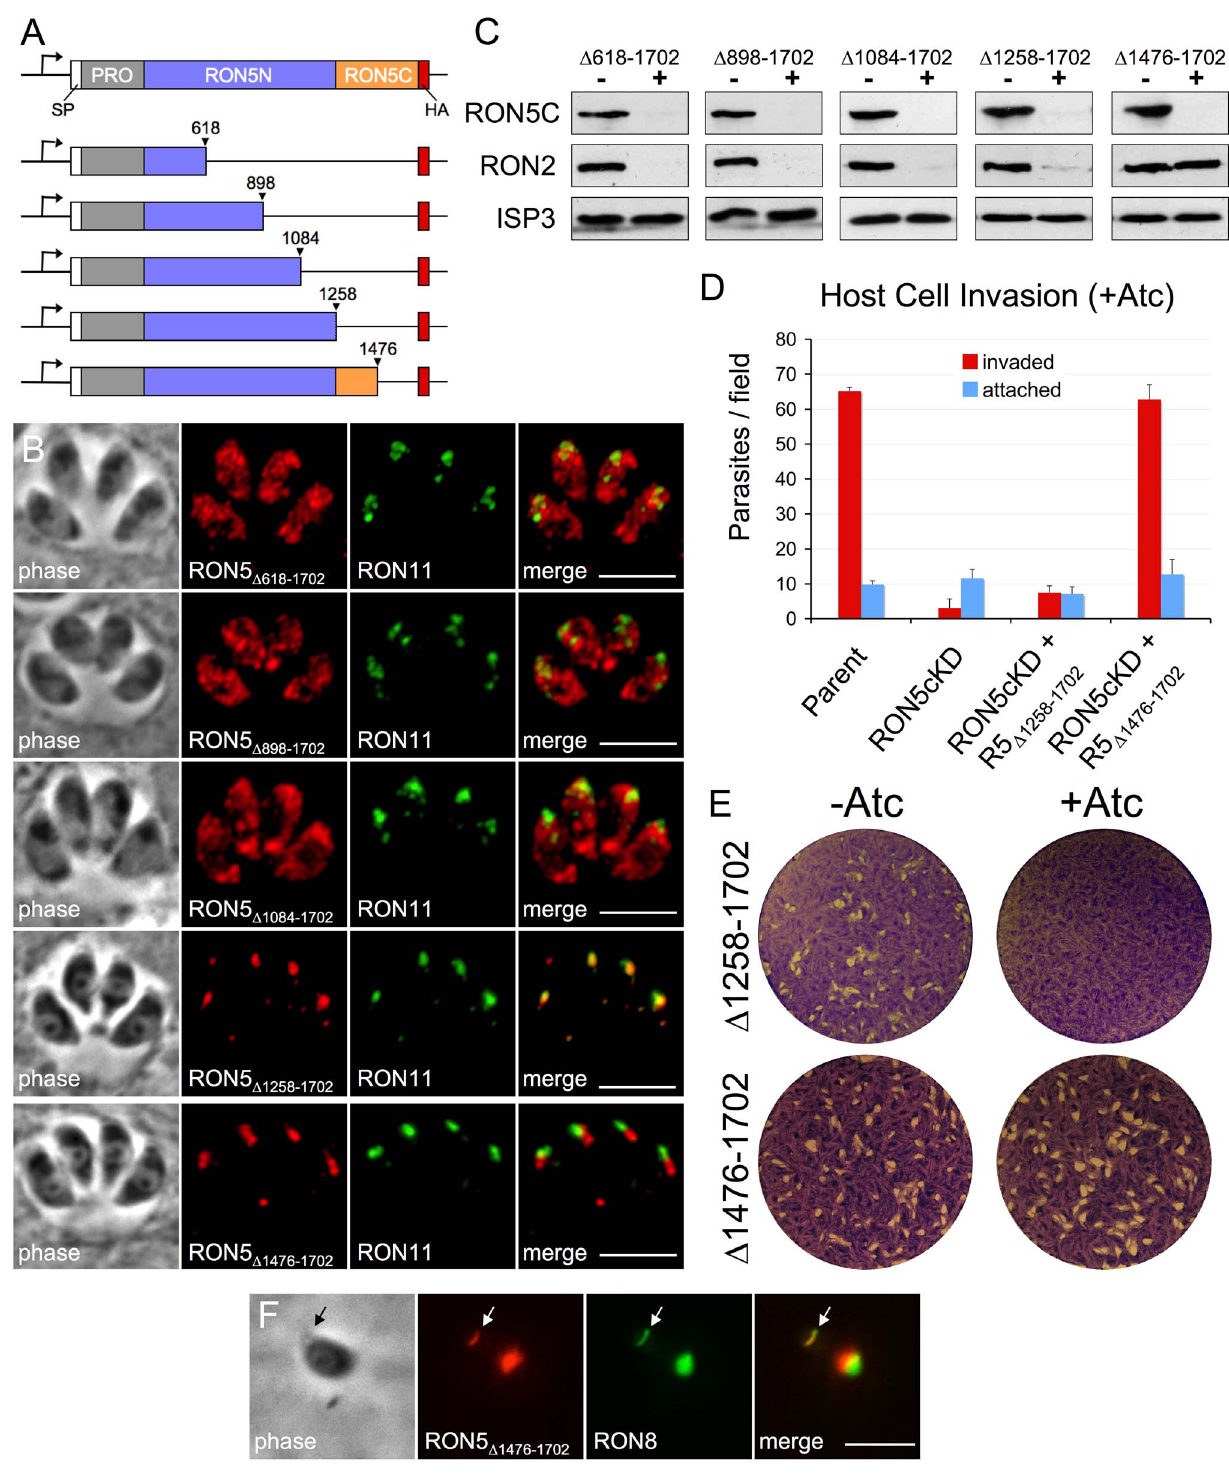
Figure 7. RON5C is required to stabilize RON2. (A) Diagram showing design of a series of C-terminal truncations of RON5. Truncation mutants each containing a C-terminal HA tag and were expressed from the UPRT locus. (B) IFA showing localization of indicated RON5 truncation mutants. Gross mislocalization is seen for the D 618-1702, D 898-1702 and D 1084-1702 truncations. In contrast, the D 1258-1702 and D 1476-1702 truncations were found to target to the rhoptry necks as assessed by co-localization RON11. A slightly more posterior localization relative to RON11 was observed for RON5 D 1476-1702 . Red: rabbit anti-HA antibody detected by Alexa594-anti-rabbit IgG. Green: rat anti-RON11 antibody detected by Alexa488-anti-rat IgG. All scale bars=5 m m. (C) Western blot assessing the ability of various RON5 truncation mutants to rescue stability of RON2 in the absence of endogenous RON5. RON2 levels were compared following 72 hours of Atc treatment in RON5 MYC cKD parasites complemented with a series of RON5 truncation mutants. Endogenous RON5C levels were monitored with an anti-MYC antibody to ensure depletion of endogenous RON5. Complete degradation of RON2 is still observed in cells complemented with the D 618-1702, D 898-1702, D 1084-1702 and D 1258-1702 RON5 truncation mutants.